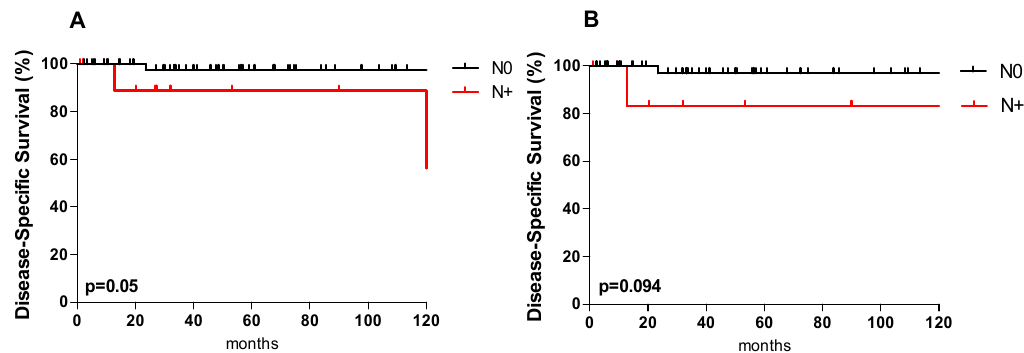
Figure 2. Disease-specific survival and nodal involvement. Kaplan–Meier disease-specific survival curves according to nodal involvement (N+ vs. N0) in the entire cohort (A) and for patients with T1 and T2 tumors (B) .